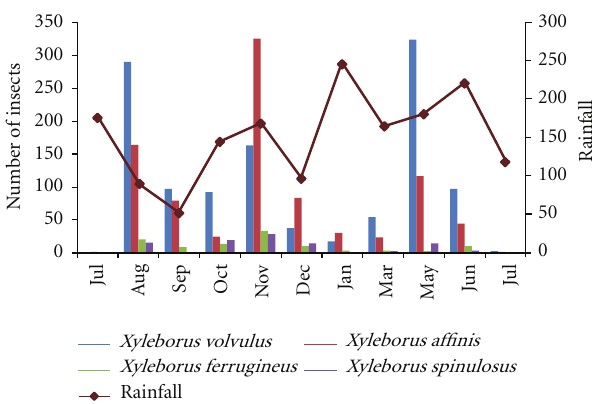
Figure 2: Monthly rainfall and total number of four of the most abundant species of Scolytinae subfamily collected with pitfall traps from July 2005 to July 2006, in primary forest of Central